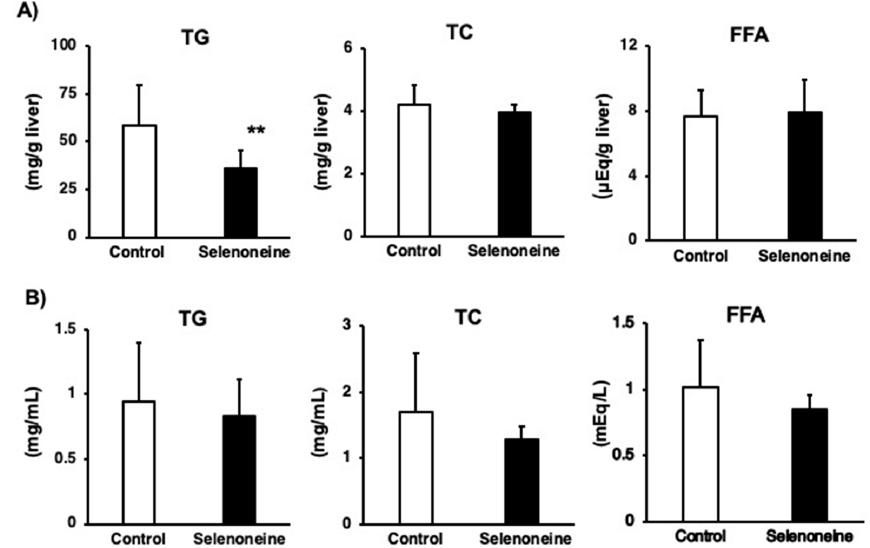
Figure 7. Changes in hepatic and serum lipid levels. ( A ) Hepatic lipid levels. ( B ) Serum lipid levels. Mice were supplemented with 0.3-mg Se/kg selenoneine for 4 months. Values are presented as mean ± SD ( n = 8). Significant differences were assessed by the Student’s t- test (**, p < 0.01 vs. corresponding control mice). TG, triglyceride; TC, total cholesterol; FFA, free fatty acid.